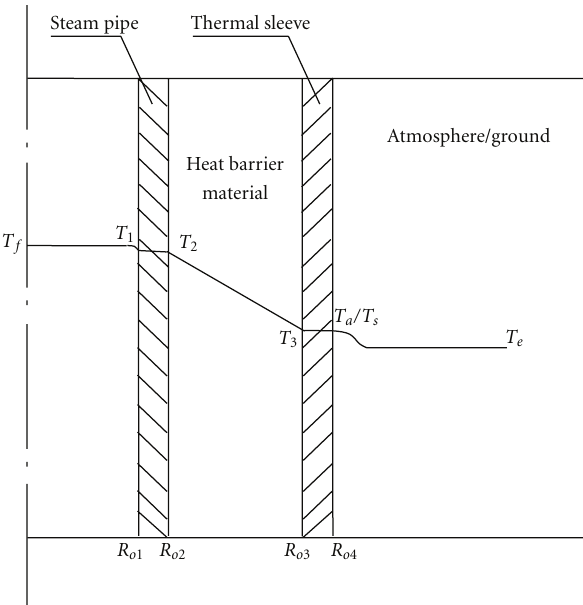
Figure 8: Structure of overground or underground pipeline.